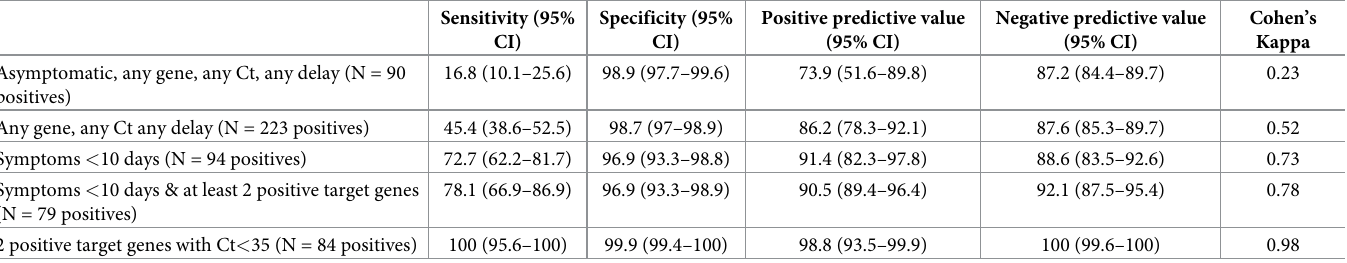
Table 2. Diagnostic accuracy of COVID-19 RT-PCR on saliva samples relative to nasopharyngeal samples considering different patient groups and Ct